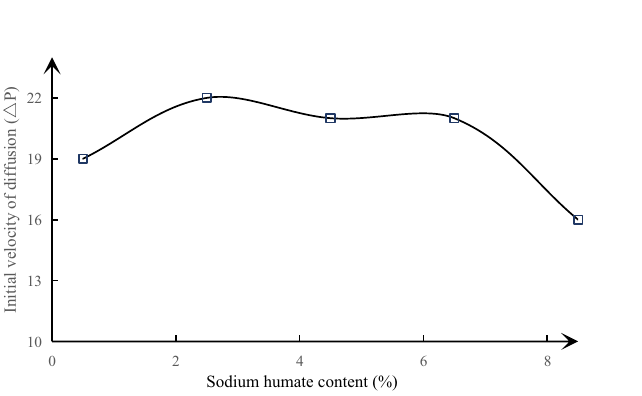
Figure 9. The curve of sodium humate content and adsorption constant b under the condition of fixed pulverized coal ratio and river sand content.